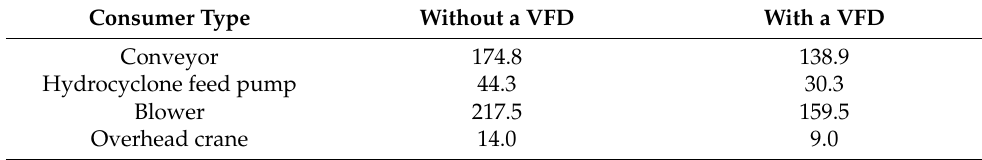
Table 2. Average values of consumed active power ( P av ), in kW, for the test period.